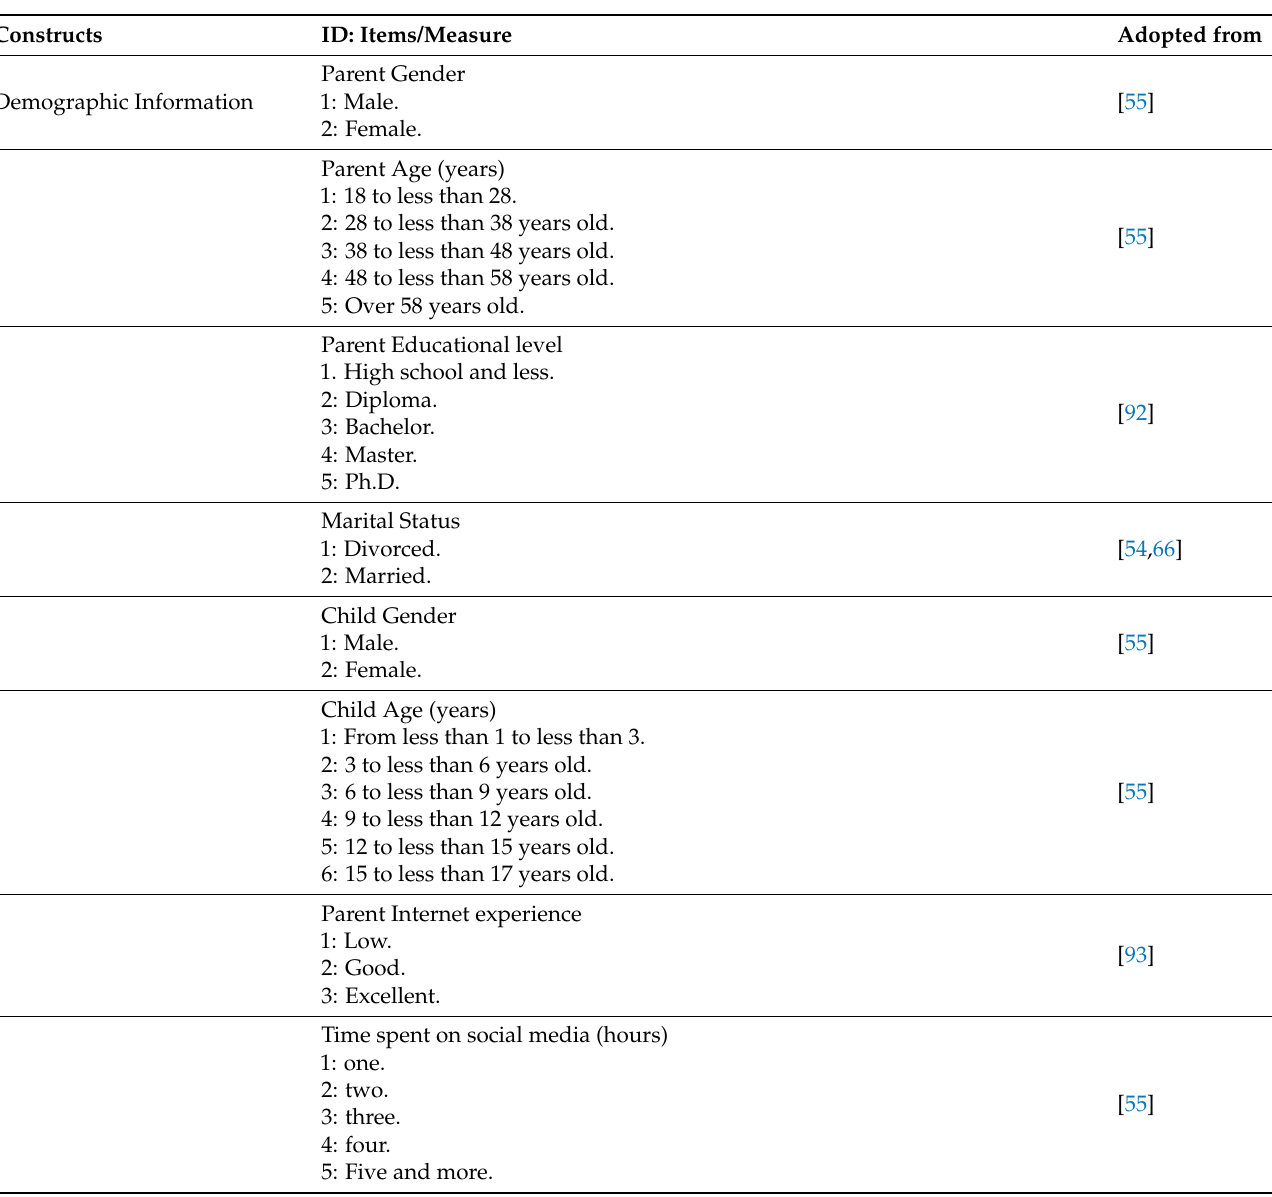
Table A1. Constructs and